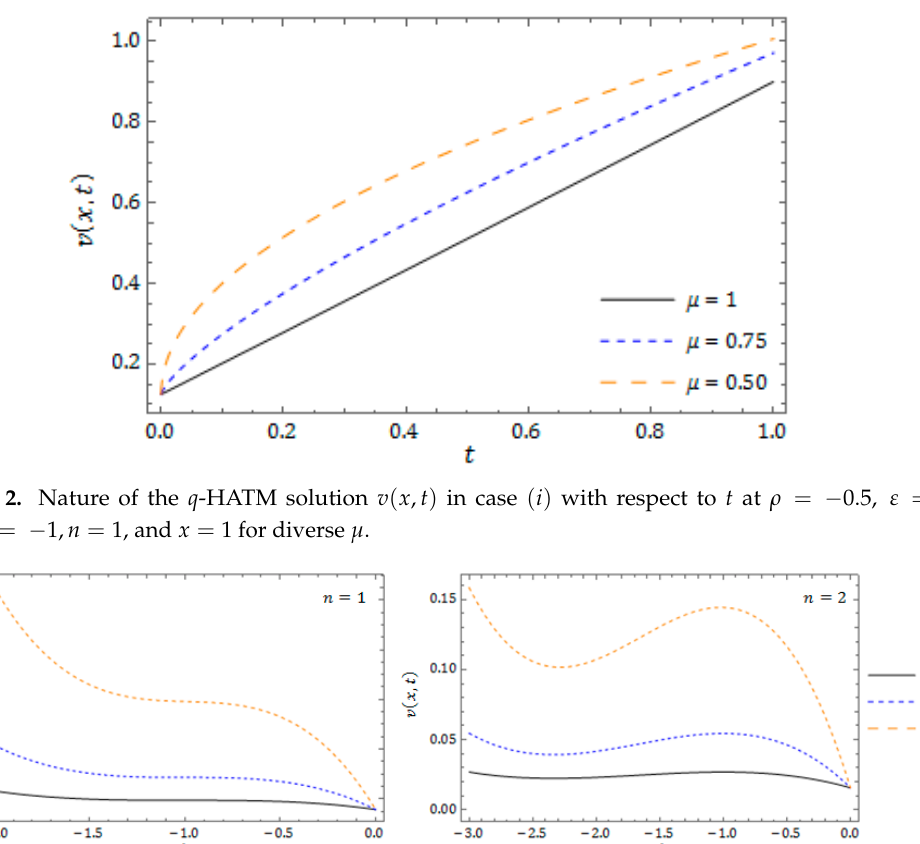
Figure 1 . (a) Response of the q-homotopy analysis transform method ( 𝑞 -HATM) solution. (b) Nature of Exact solution. (c) Surface of Absolute error = (cid:3627)𝑣 (cid:3006)(cid:3051)(cid:3028)(cid:3030)(cid:3047) − 𝑣 (cid:3044)(cid:2879)(cid:3009)(cid:3002)(cid:3021)(cid:3014) (cid:3627) for case (𝑖) at 𝜌 = −0.5,𝜀 = 0.5, ℏ = −1,𝑛 = 1 , and 𝜇 = 1.